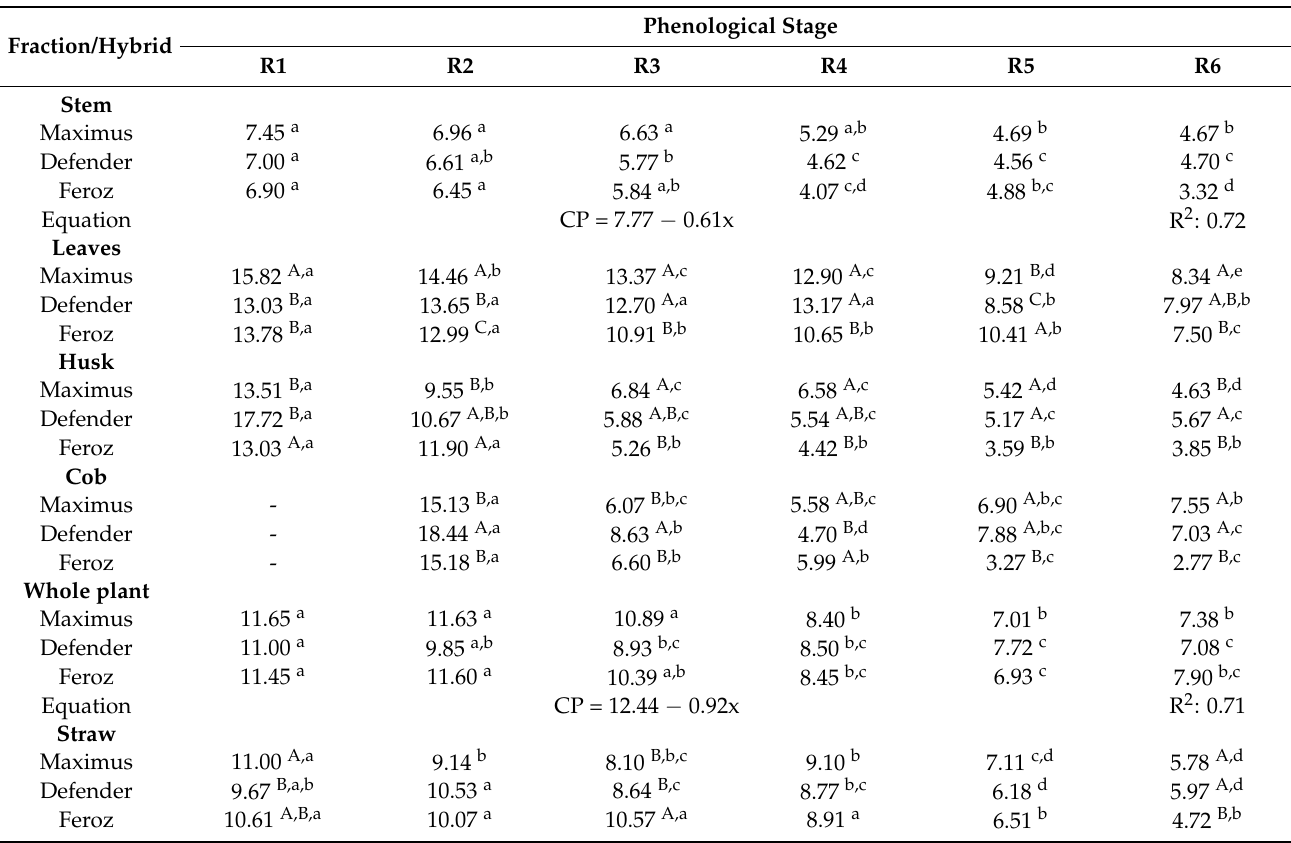
Table 2. Crude protein (% of DM) of the whole plant and the fractions of three maize hybrids harvested at the beginning of the six reproductive stages of